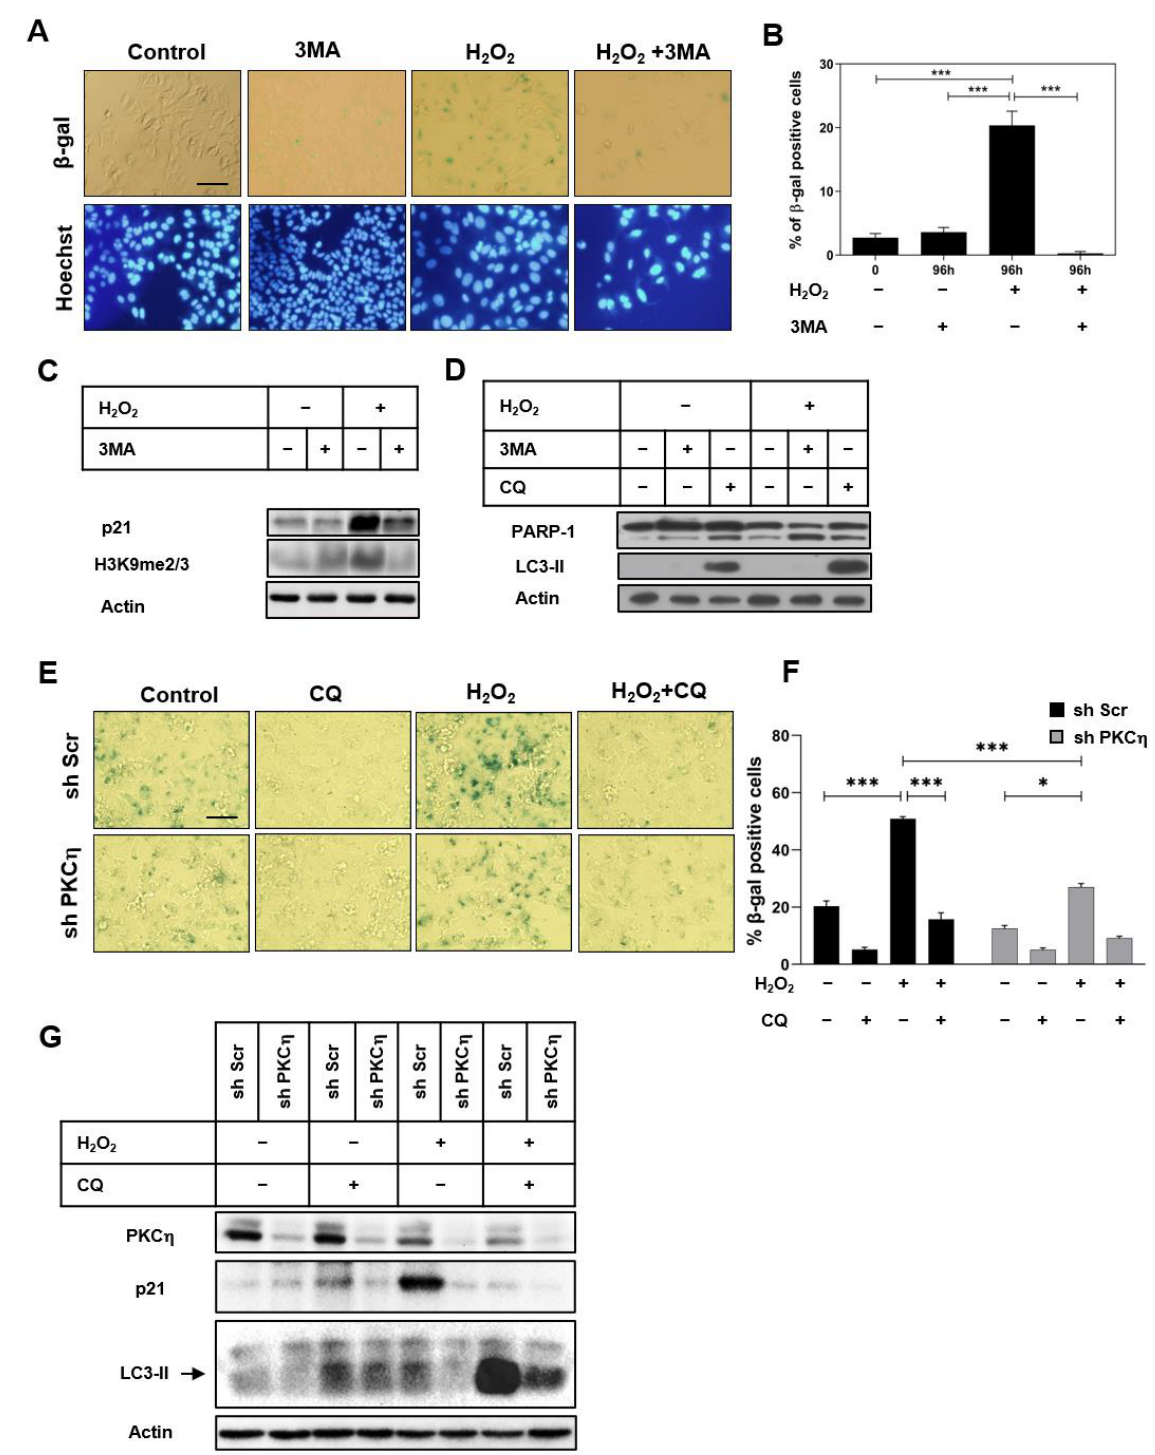
Figure 3. Inhibition of autophagy attenuates the induction of senescence by PKC η . ( A ) Sub-confluent MCF-7 cells were treated with 3MA (1 mM) for 1 h in serum-free medium, followed by the addition of H 2 O 2 (150 µ M) for 2 h. Fresh growth medium was added for 96 h. Cells were stained for SA- β -gal, and the nuclei were stained with Hoechst. Images were taken by a fluorescence inverted